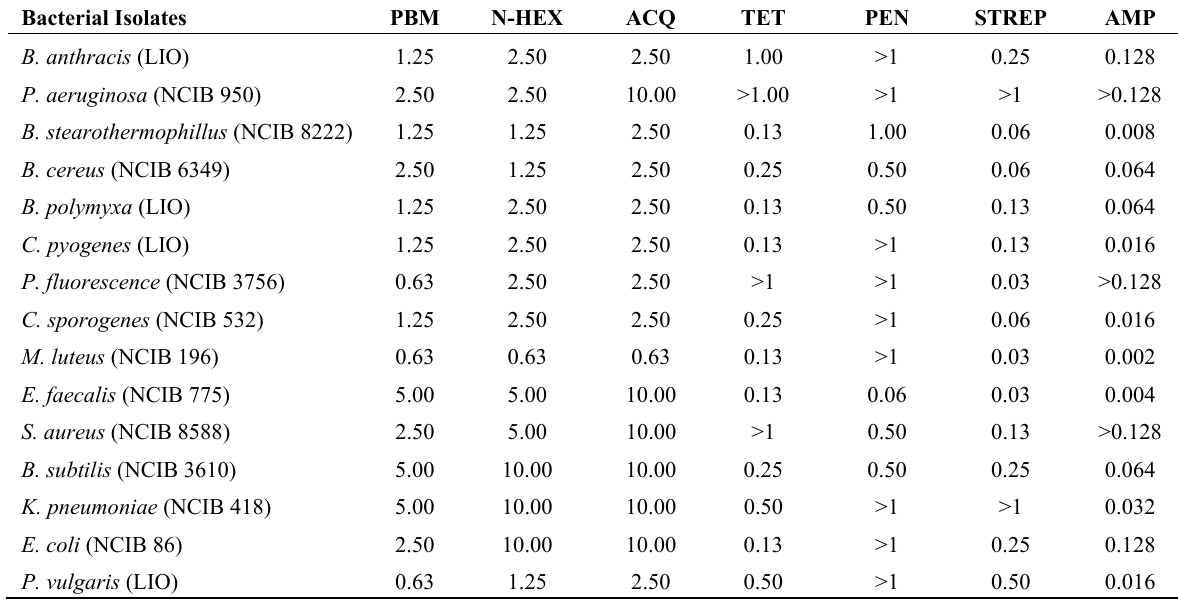
Table 4. The minimum inhibitory concentrations (mg/mL) of the methanolic extract, n -hexane and aqueous fractions and standard antibiotics against bacterial